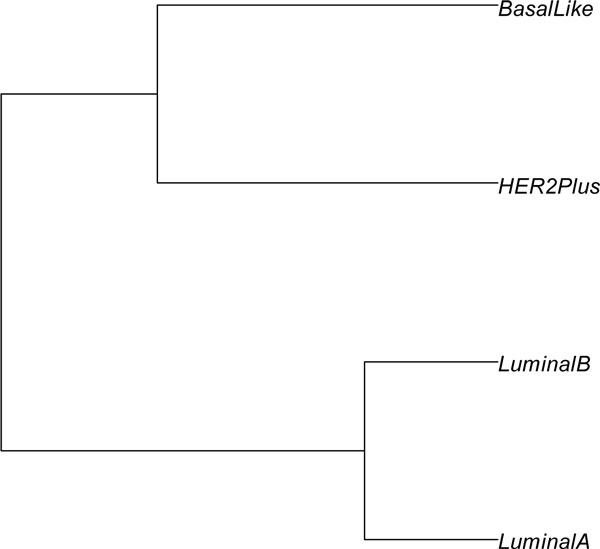
dendrogram of primary breast cancers from the cancer genome atlas network. The summary of the genomic, clinical and proteomic features of subtypes from the Cancer Genome Atlas Network, which includes the percentage of ER+/HER2-, HER2+, TNBCs, TP53 pathway, PIK3CA/PTEN pathway, RB1 pathway and DNA mutations, was used to draw the phylogenetic tree with hierarchical cluster analysis under Euclidean distance metric.